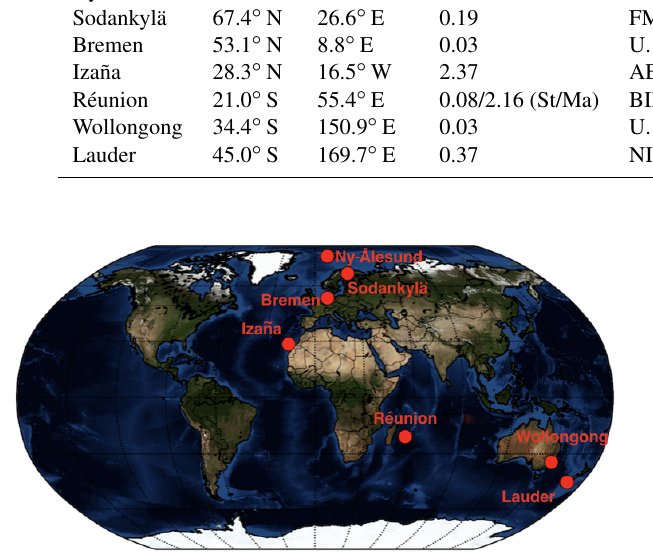
Figure 1. The location of the FTIR sites providing both TCCON and NDACC N 2 O measurements used in this